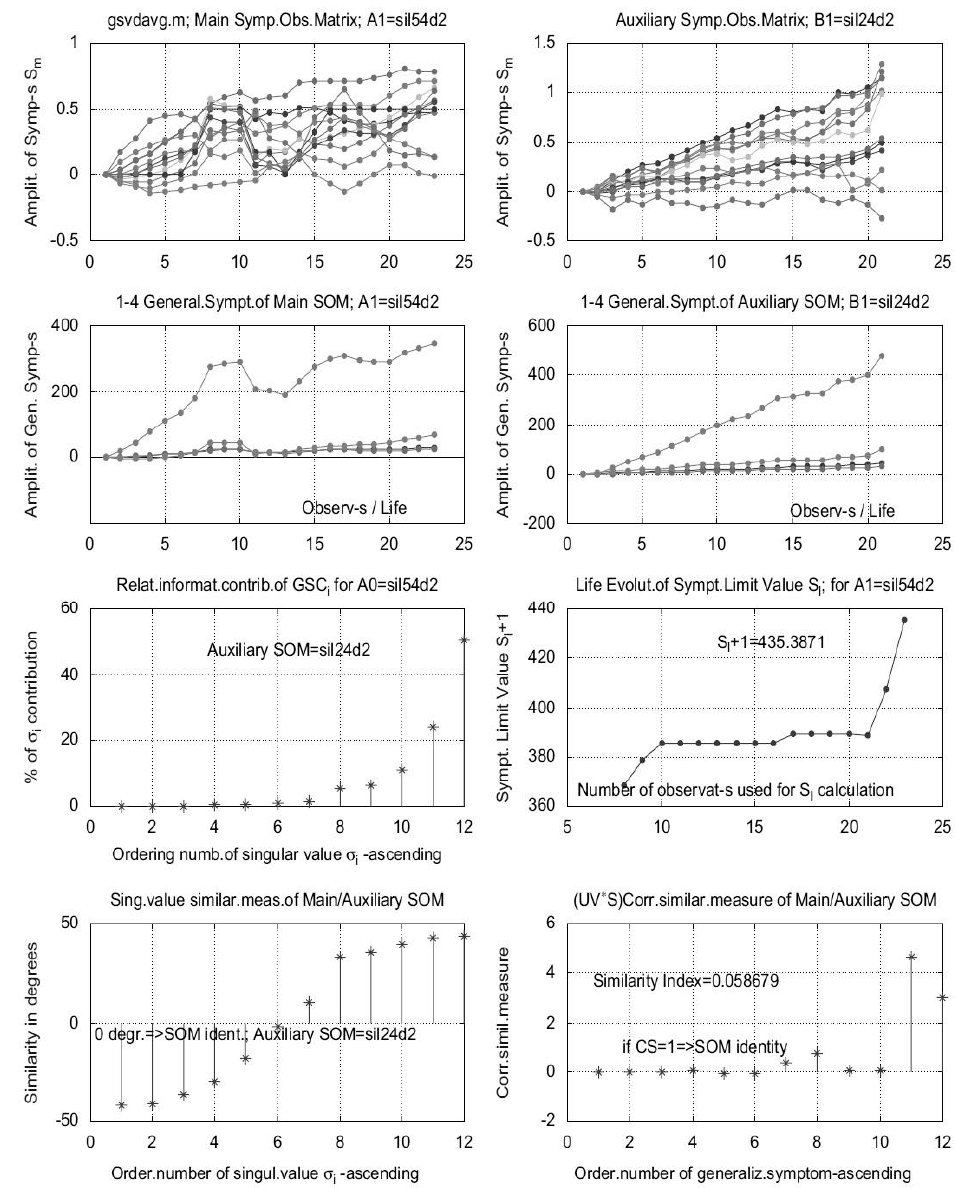
Figure 6. GSVD comparison of two different examples of the same diesel engines [78]. Reprinted with permission from ref. [78]. Copyright 2021 Elsevier.